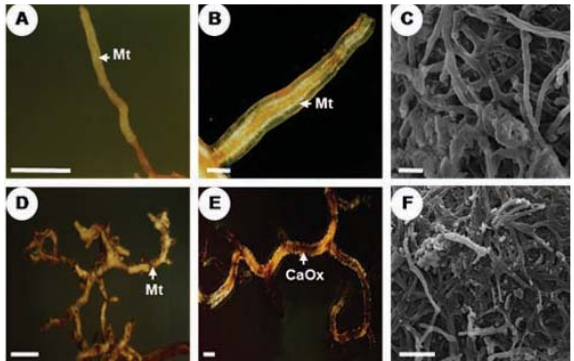
Figura 4. Morfologia de ectomicorrizas de híbrido de Eucalyptus grandis x Eucalyptus urophylla , coletadas na baixada de área com topografia típica em meia laranja de vertente côncavo- convexa, e observadas por microscopia óptica (A, D); por microscopia óptica de luz polarizada, para visualização de cristais de oxalato de cálcio (CaOx) (B, E); e por microscopia eletrônica de varredura (C, F). As três fotos horizontais correspondem a um morfotipo distinto. Os CaOx aparecem como pontos brilhantes nas estruturas diafanizadas. Observar manto micorrízico (Mt), e diferenças na distribuição de CaOx entre os diferentes morfotipos de ectomicorriza. Barras: A e D = 1 mm; B e E